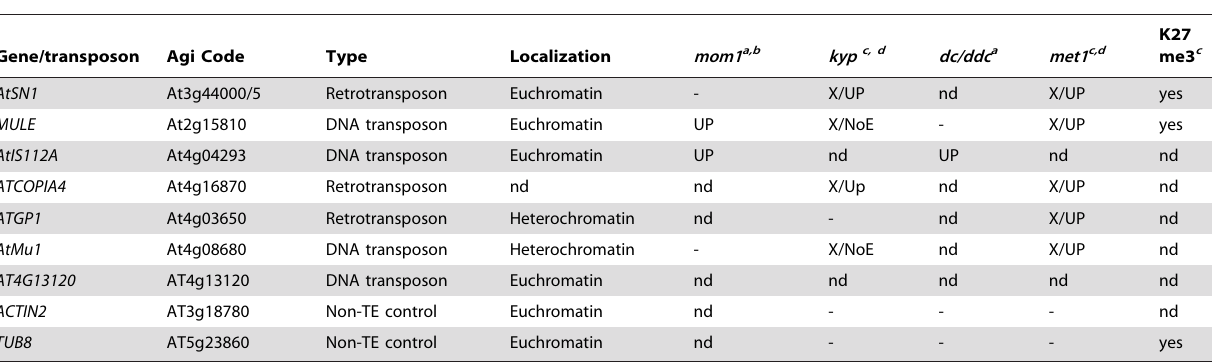
Table 1. Transposon expression in various mutant backgrounds.